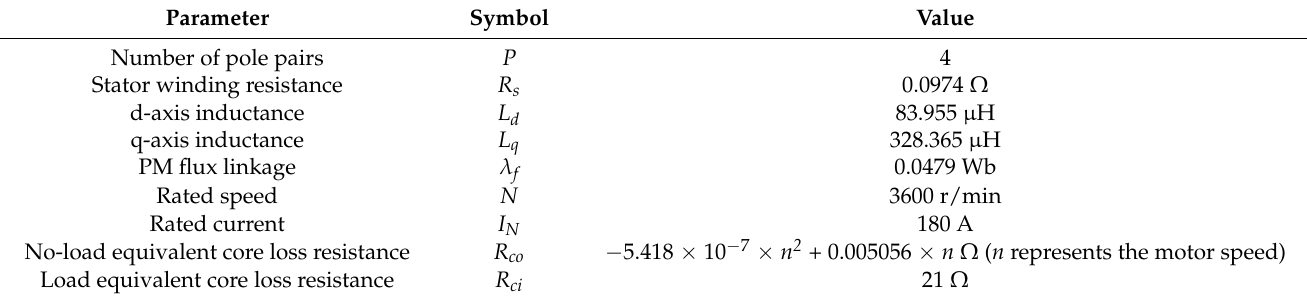
Table 1. Parameters of the